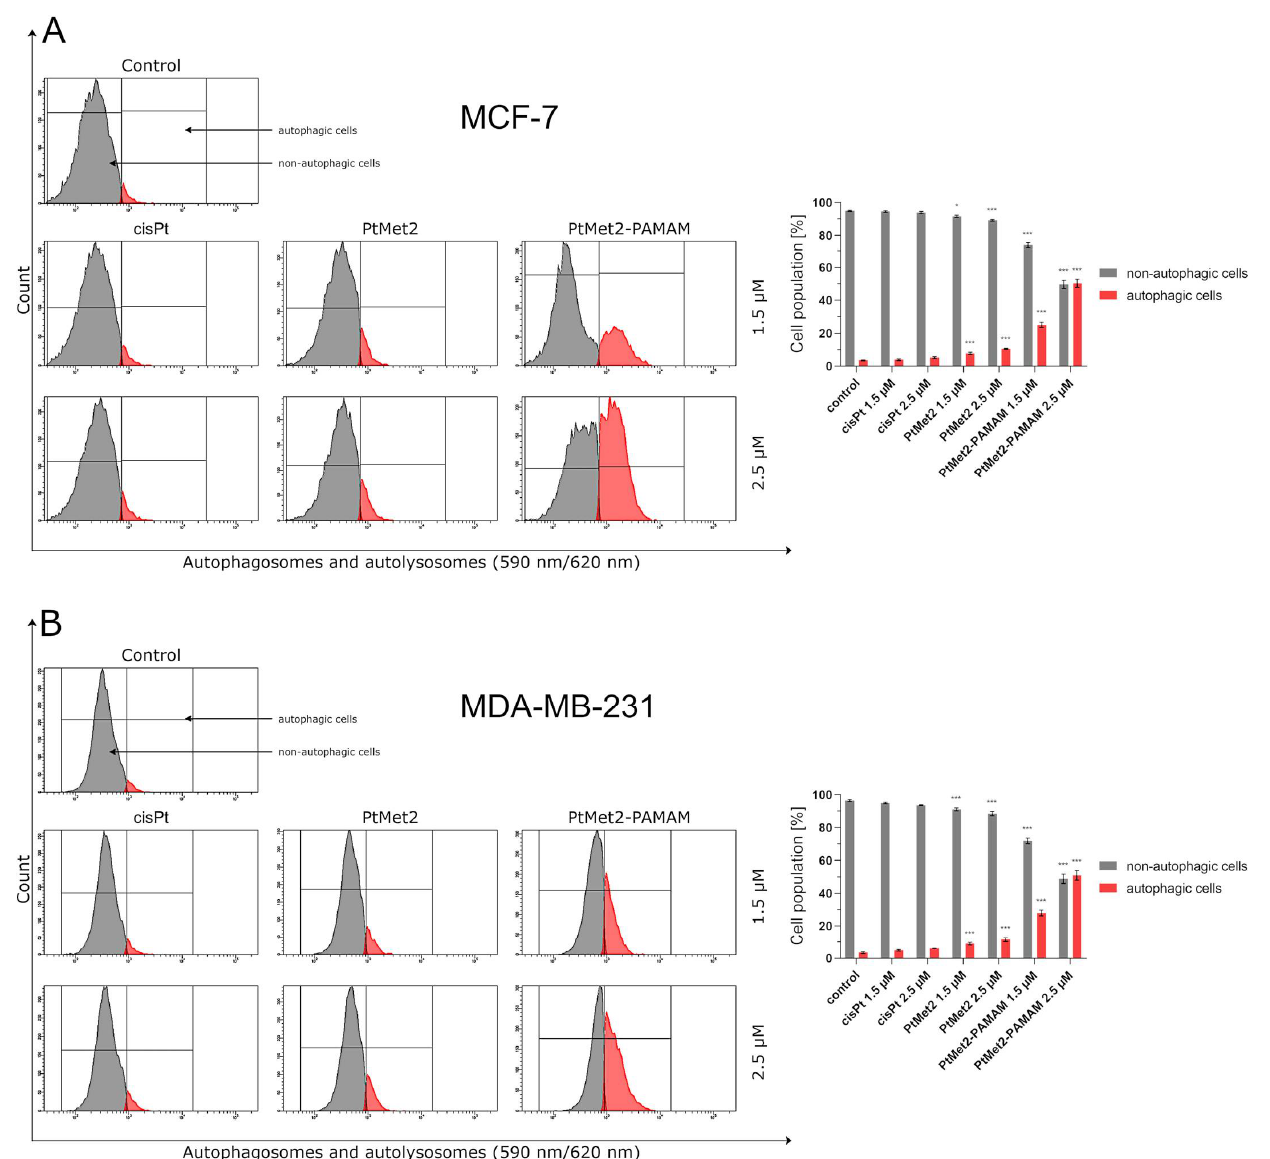
Figure 10. Autophagy induction in MCF-7 ( A ) and MDA-MB-231 ( B ) breast cancer cells measured by flow cytometry using Autophagy Probe (red color) compared to negative control cells (gray color) after 24 h of incubation with PtMet2, PtMet2–PAMAM, and cisplatin (1.5 μM and 2.5 μM). Mean percentage values from three independent experiments ( n = 3) done in duplicate are presented. * p < 0.05 vs. control group, *** p < 0.001 vs. control group.